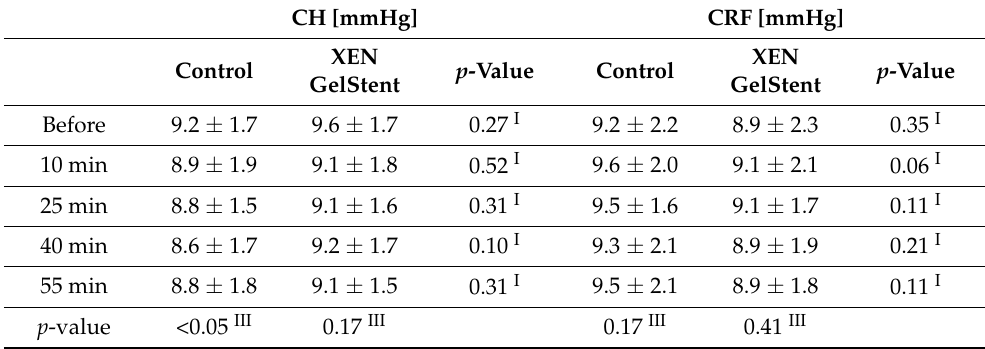
XEN p -Value GelStent